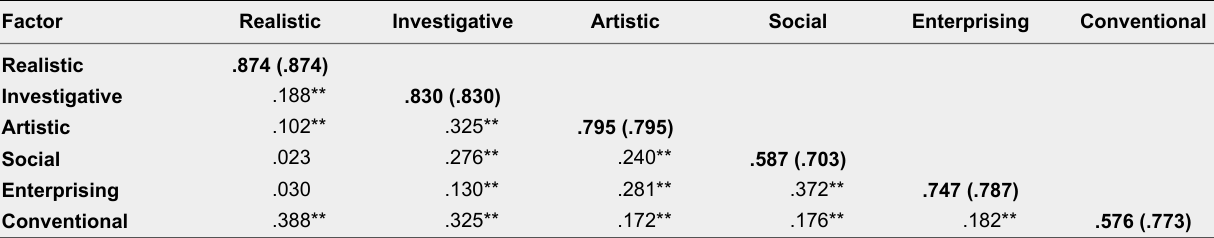
Pearson Correlations Matrix Between the Six RIASEC Factors